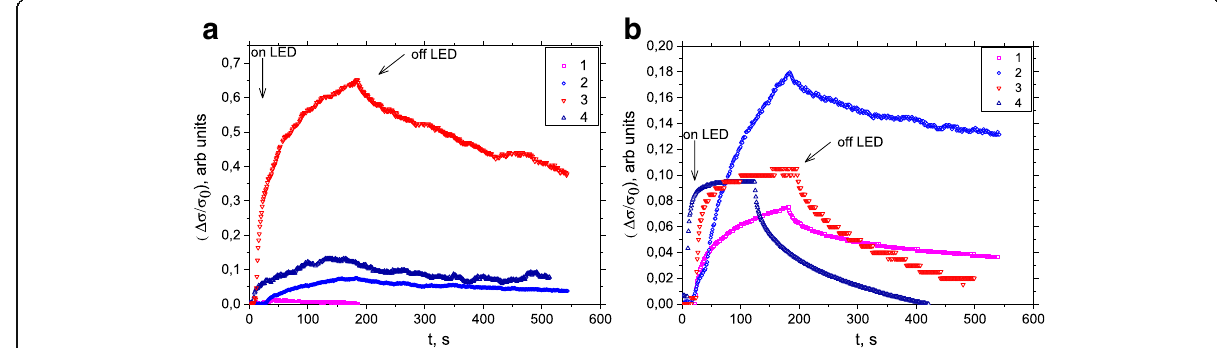
Fig. 4 Photoconduction of the samples ( 1 PLD, 2 PLD-200A, 3 PLD-300, and 4 PLD-400) thin film ZnO as-growth ( a ) and annealed ( b )